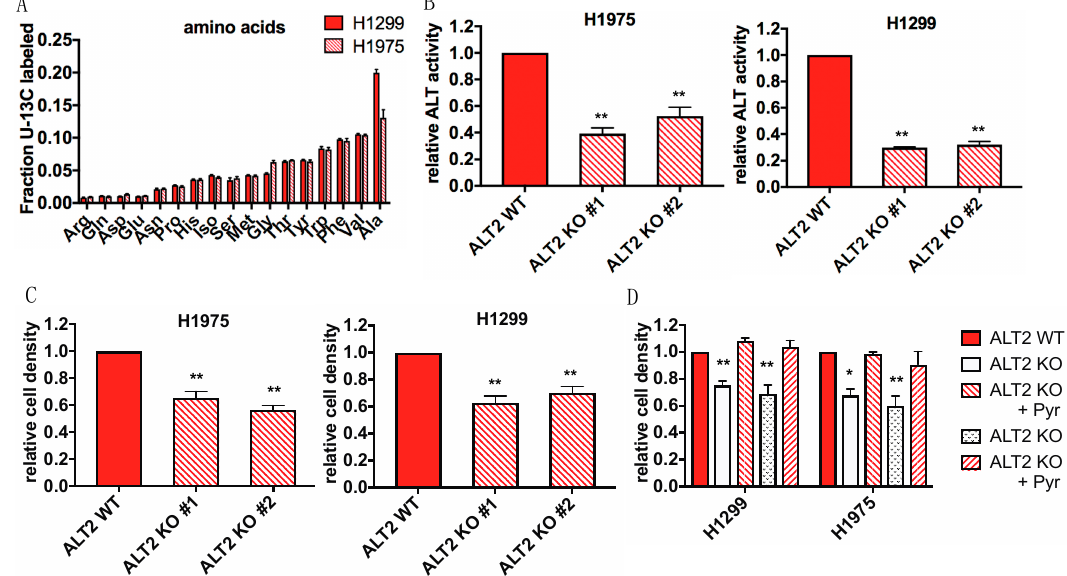
Figure 6. Alanine is derived from internalized protein and is converted to pyruvate by ALT2 to support proliferation during glucose starvation. ( A ) Detection of universally (U) 13 C -labeled amino acids in cells cultured in GFM supplemented with unlabeled or U- 13 C labeled yeast protein by LC-MS. Values are presented as a ratio of U- 13 C labeled amino acid to total amino acid abundance, Error bars indicate ± SD of three biological replicates. ( B ) Relative ALT activity of ALT2 WT and ALT2 KO H1299 and H1975 cell lysates. Data is normalized to ALT2 WT cells. ( C ) Relative density of ALT2 WT and ALT2 KO H1299 and H1975 cells cultured in GFM for 48 h. Data is normalized to density of ALT2 WT cells at 48 h. For ( B , C ), Significance was calculated using Student’s t -test. ( D ) Relative density of glucose starved ALT2 WT and ALT2 KO H1299 and H1975 cells supplemented with vehicle or 1 mM pyruvate (Pyr). Data is normalized to density of vehicle treated ALT2 WT cells at 48 h. Significance was calculated using ANOVA with Holm-Sidak multiple comparisons to ALT WT cell lines. For ( B – D ), error bars indicate ± SEM of at least three independent experiments, * p < 0.05, ** p < 0.005.